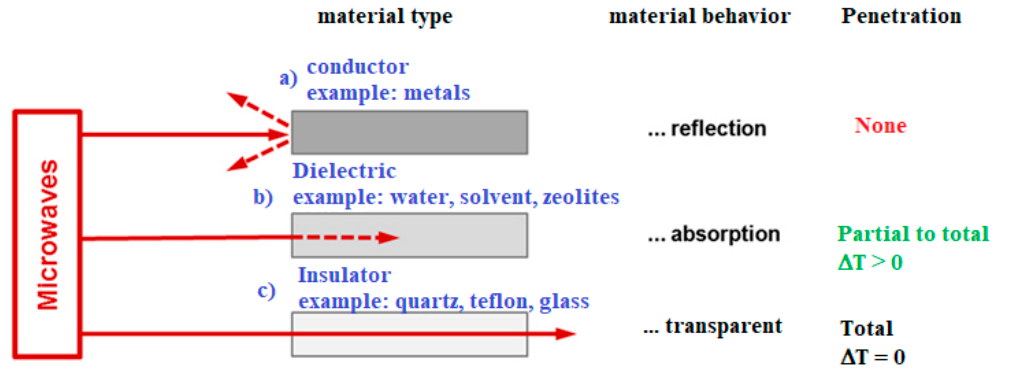
Figure 5. Microwaves and solids, ( a ) conductors, ( b ) dielectric lossy materials, ( c ) insulators. A general classification proposed in literature [8], divided the heterogeneous catalysts field into three big areas: